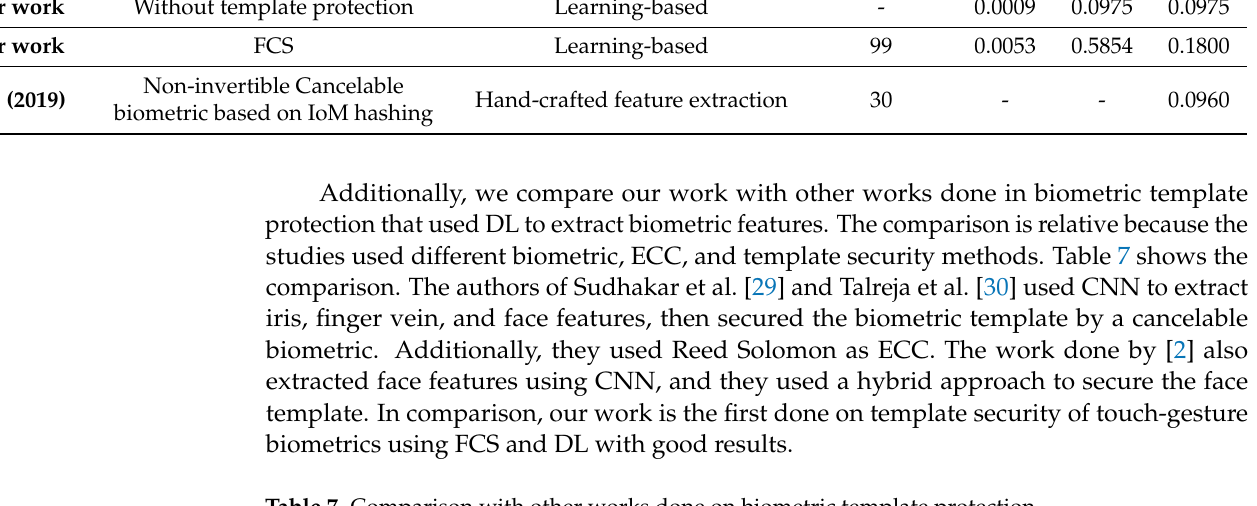
Table 7. Comparison with other works done on biometric template